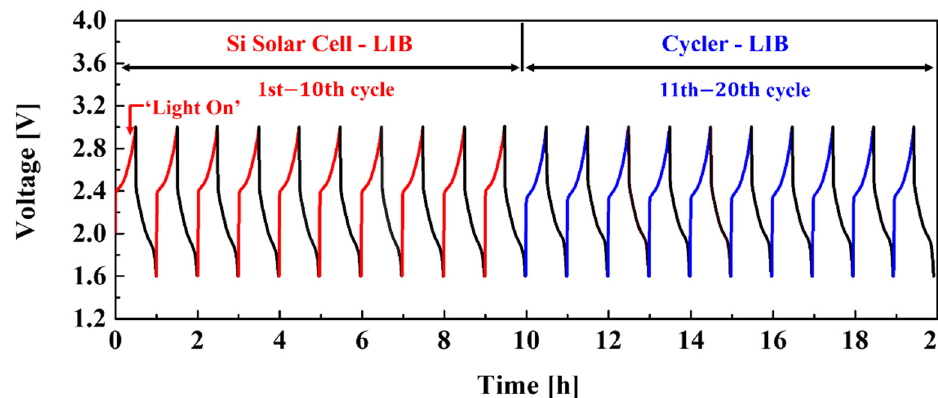
Figure 7. Photo-charging and discharging diagram of the NCM-LTO full-cell using the Si solar cell.